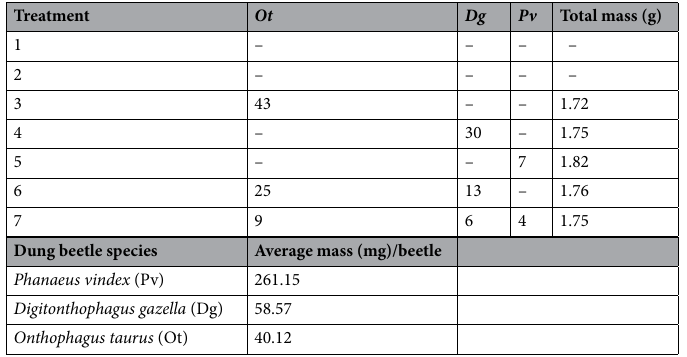
Table 1. Total number and biomass of dung beetles per treatment.